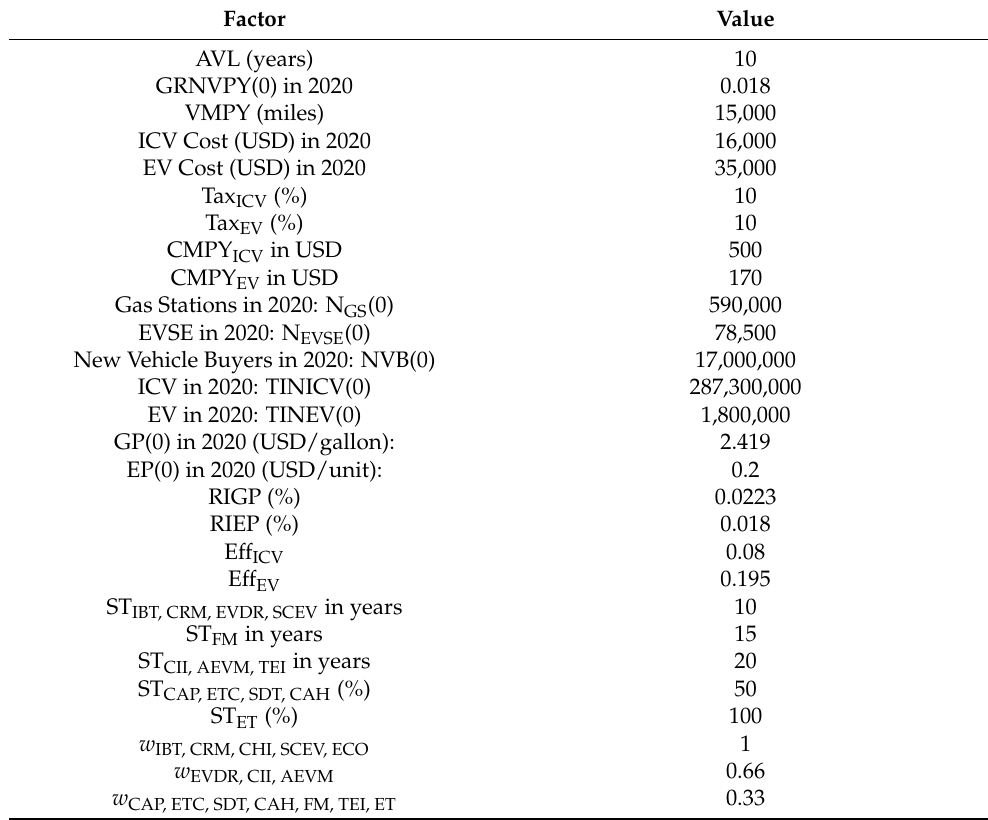
Table 2. Base values for scenario